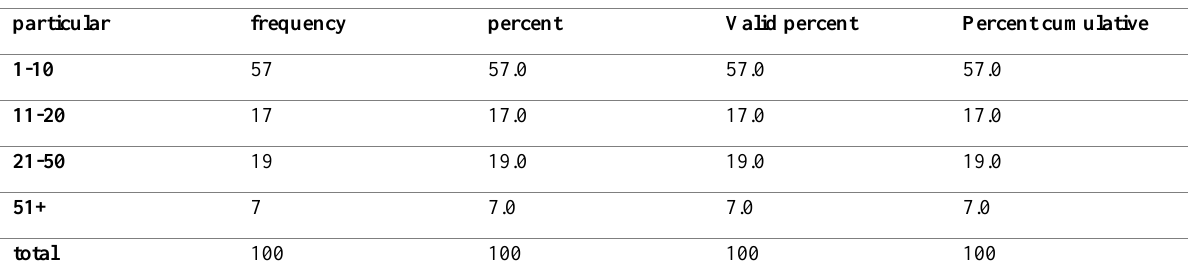
Table 4: Number of employees